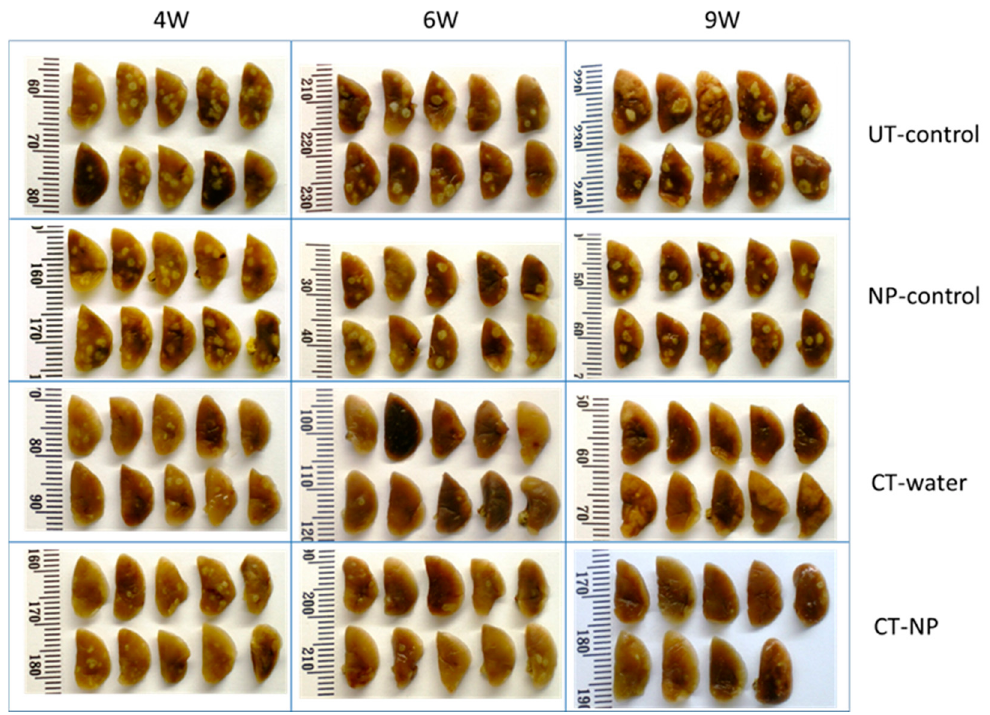
Figure 4. Visual representations of pulmonary pathology of infected animals over the experimental period with encapsulated and unencapsulated INH/RIF/PZA at four, six, and nine weeks of treatment.